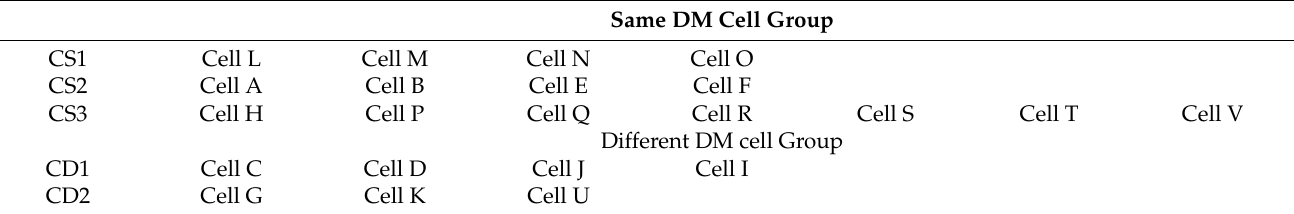
Table 6. Same and Different DM cell Groups. Same DM Cell